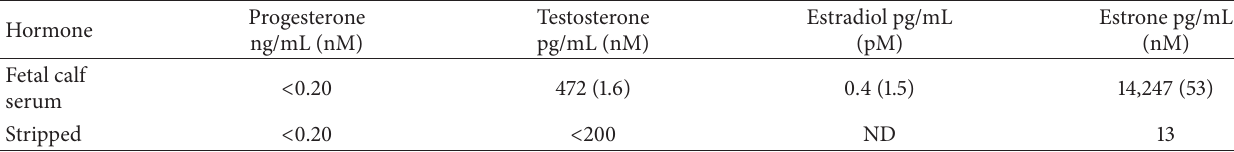
Table 1: Effects of charcoal stripping on hormone levels of calf fetal